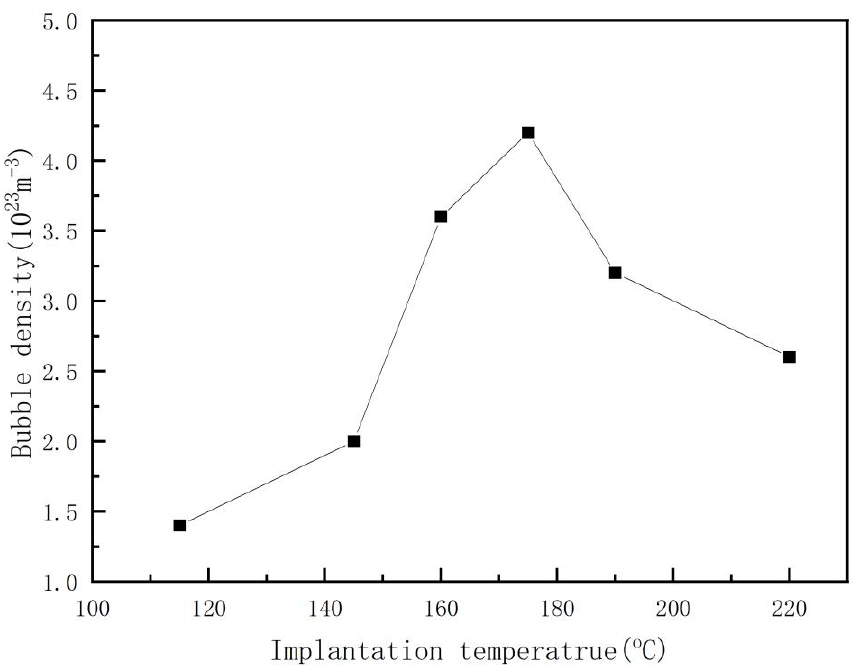
Figure 3. Dependence of the helium bubble number density distribution on the helium ion implanta- tion temperature (helium ion dose 5 × 10 16 ions/cm 2 , helium ion energy 100